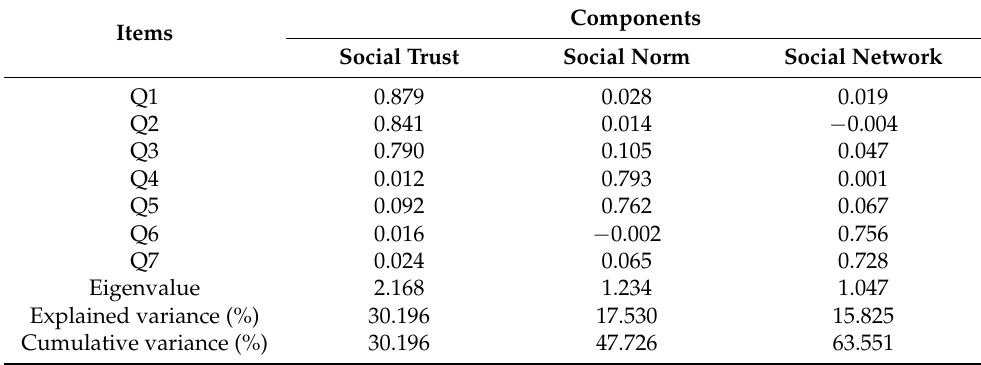
Table 3. Component matrixes for respective components of sense of place after rotation.